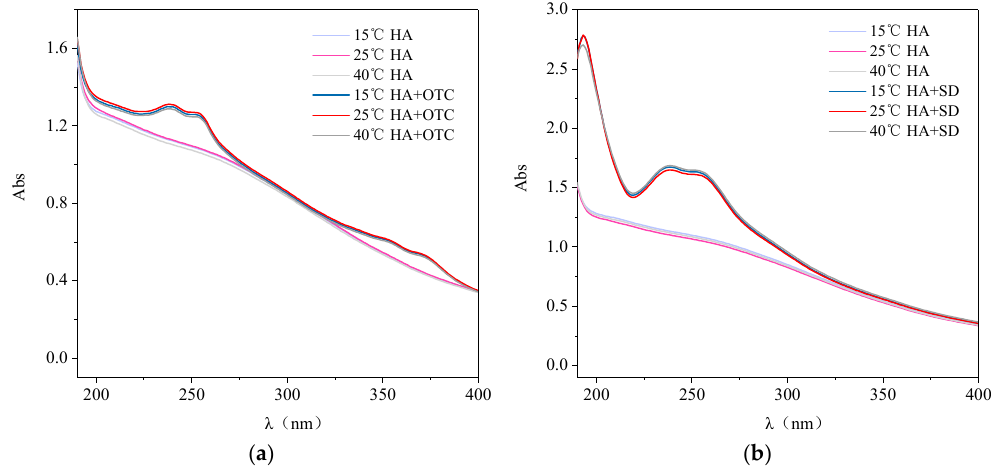
Figure 5. The interactions of OTC and SD with HA under different temperature. ( a ) OTC and ( b ) SD.